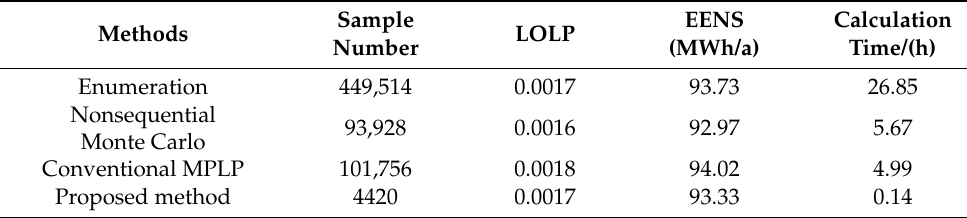
Table 4. Reliability assessment results of a provincial power grid in